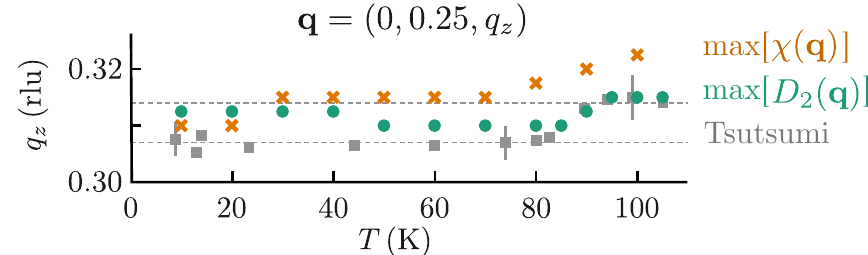
Figure 3: The temperature dependence of the position of the maximum of χ (crosses) ) , plotted alongside experimental data and D (circles) along the line q = ( 0,0.25, q z 2 reproduced from Ref. [ 21 ] (squares and dashed line fits). Note that χ is a much flatter function than D and that its shape varies strongly with minute changes in the 2 chemical potential (see also Fig. 6 of the Supplemental